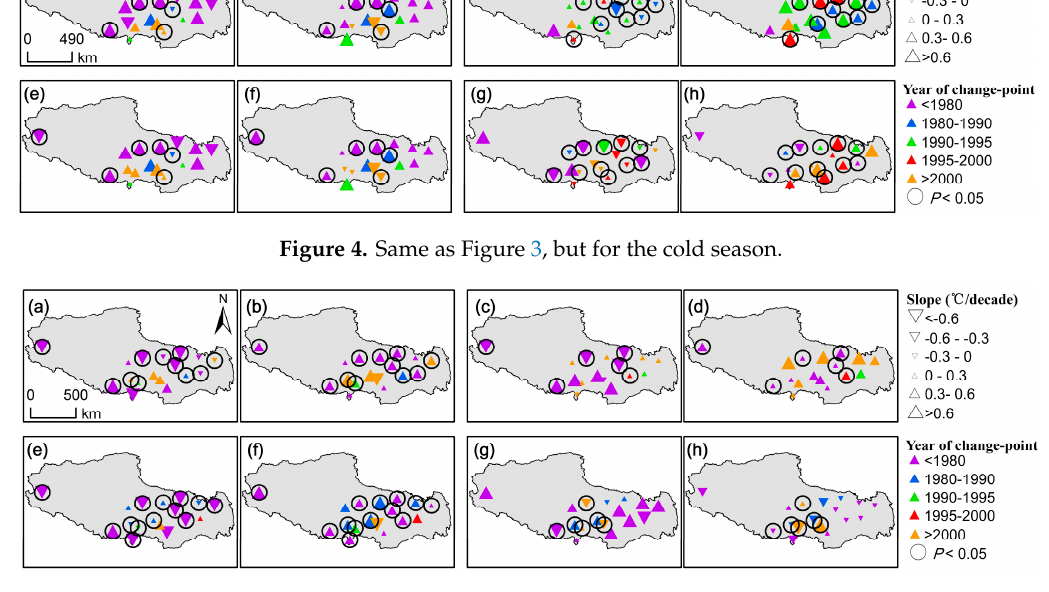
Figure 5 . Same as Figure 3, but for the warm season.